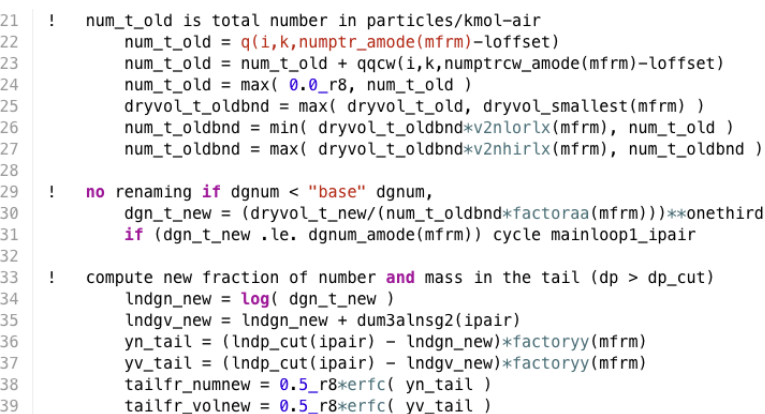
Figure 2. Part of the code lines of the compilation-sensitive code segment in the code file modal_aero_rename.F90 of CAM5. It is found that the code at line 330 can produce different results when different compiling setups are used.